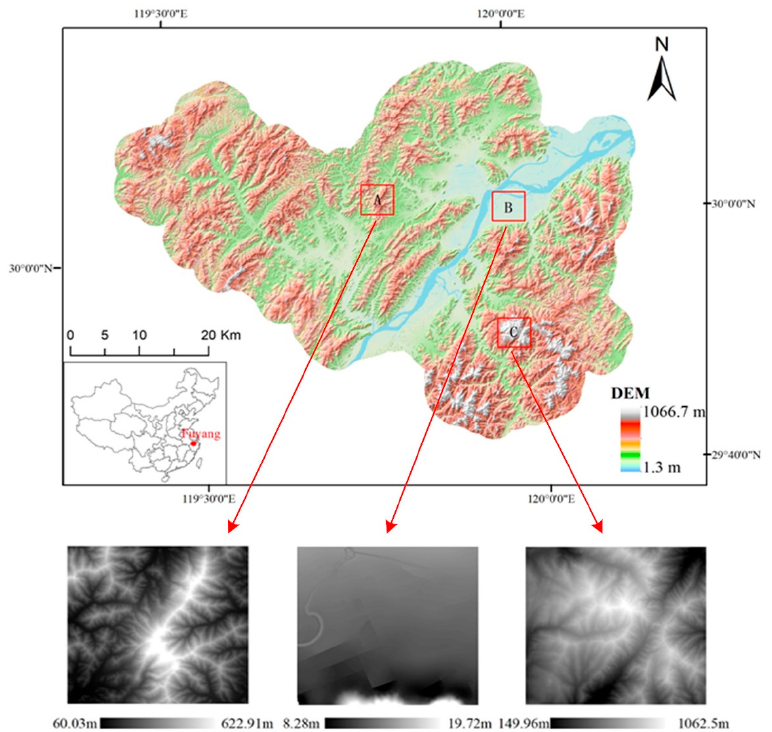
Figure 1. Map of the research area.